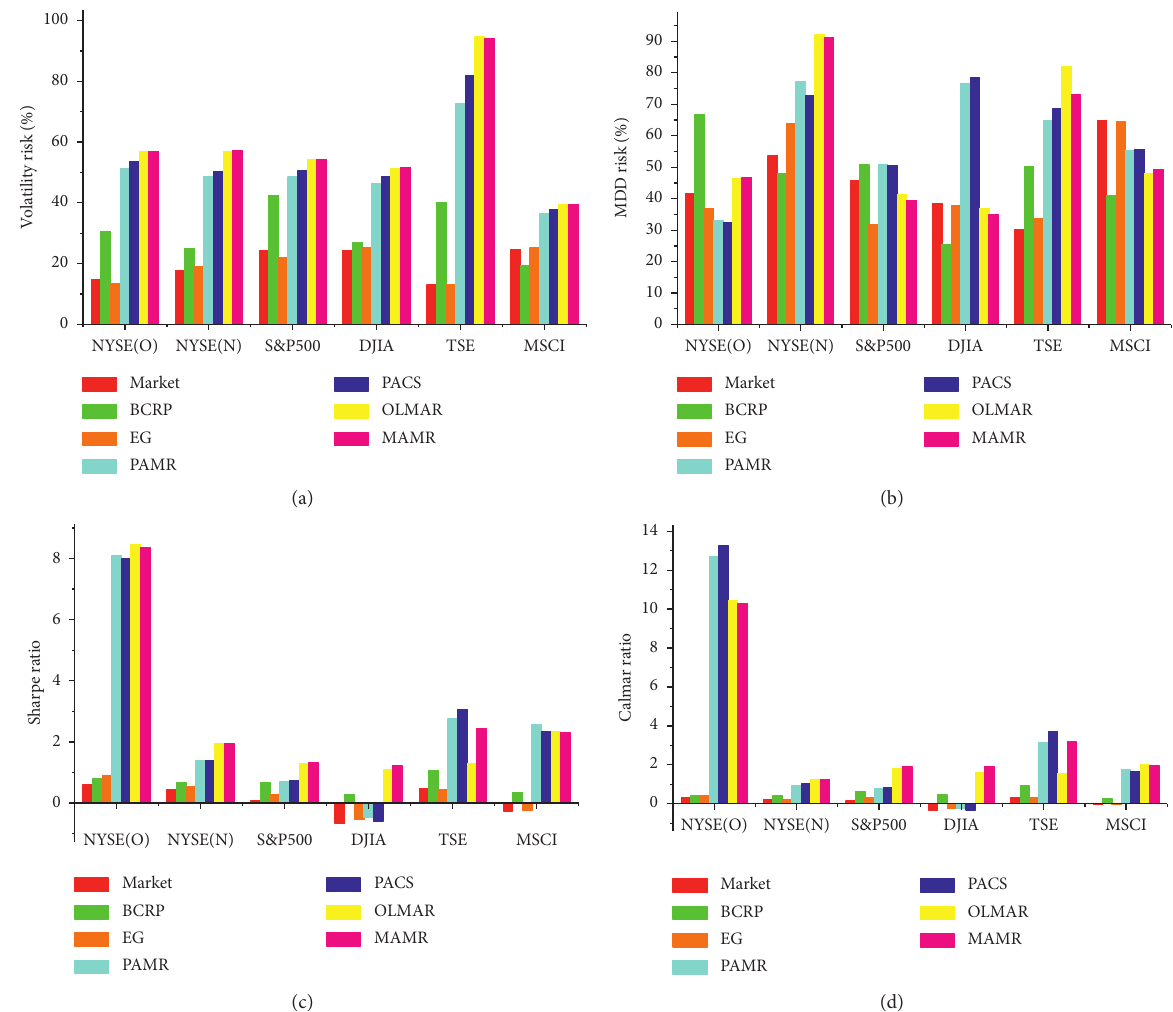
Figure 1: Risk and risk-adjusted performance of various strategies on the six different datasets. (a) Volatility risk. (b) Drawdown risk. (c) Sharpe ratio. (d) Calmar